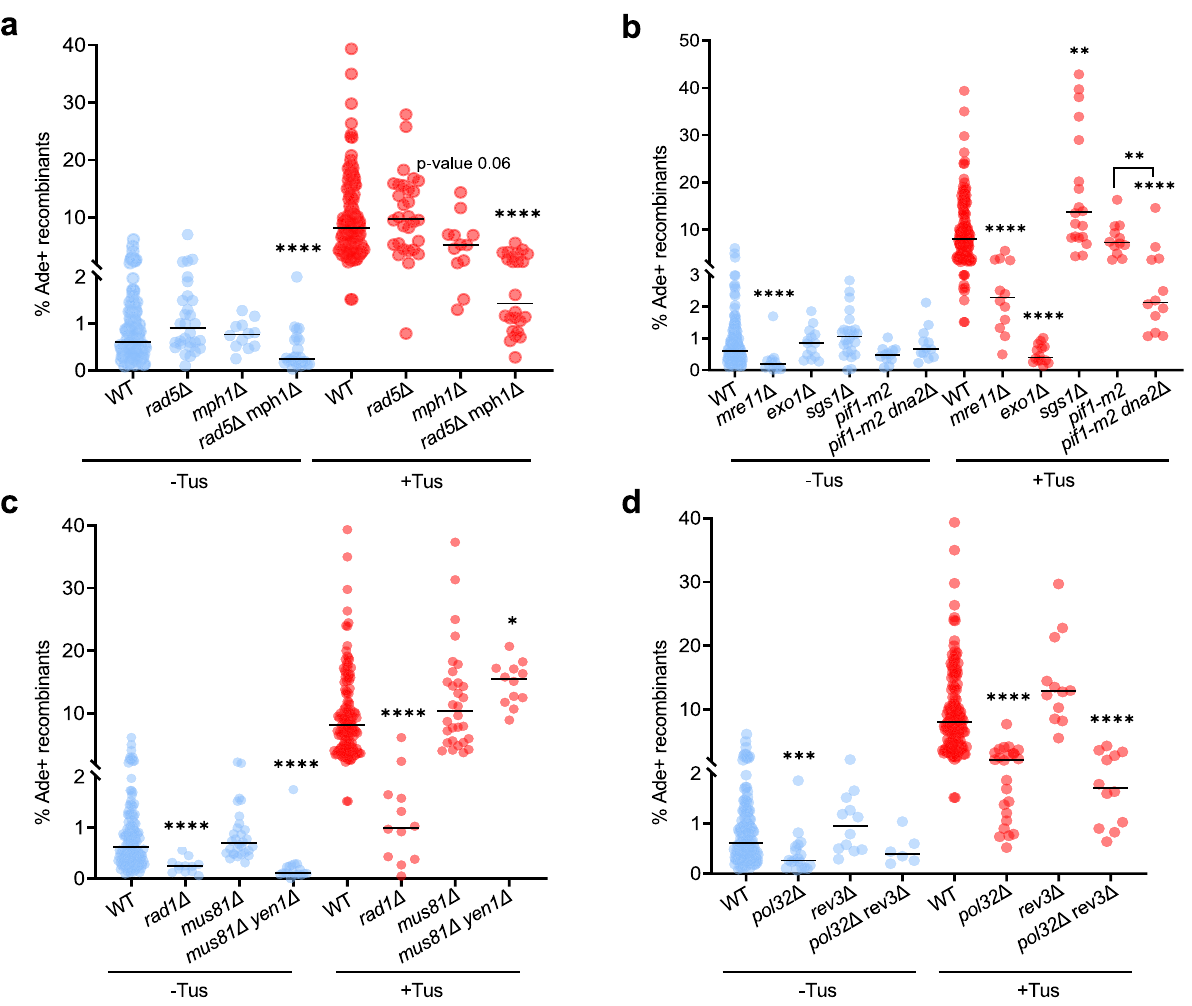
Fig. 4 Tus-induced NAHR relies on fork reversal, end resection, and DNA synthesis. a Frequency of Ade + recombinants in WT and fork remodeler mutant strains. b Ade + recombination frequencies in WT and end resection mutants. c Ade + recombination frequencies in WT and nuclease mutants. d Ade + recombination frequencies in WT and polymerase mutants. a – d Black lines indicate medians. The numbers of colonies tested for each strain are reported in Supplementary Table 1. p -values were obtained on log-transformed data by one-way ANOVA with a Bonferroni post-test and are relative to the WT strain in the same condition. They are reported as stars when signi fi cant with: * p -value < 0.05, ** p -value < 0.005, *** p -value <